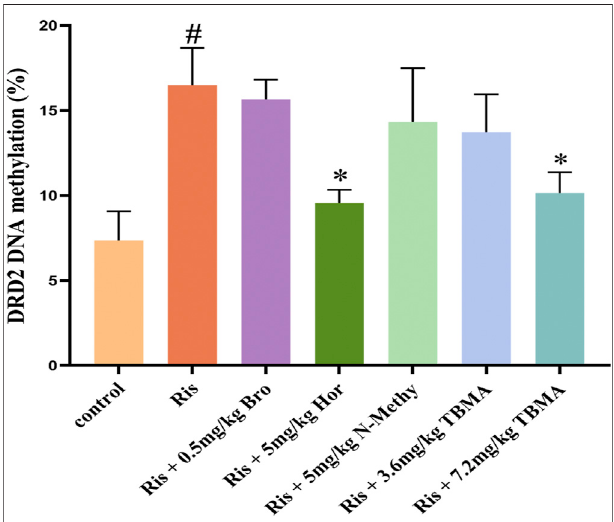
FIGURE5| DRD2methylationstatus.Dataarepresentedasthemean± SD ( n =3per group). ( # p < 0.05versusthecontrolgroup; *p < 0.05versusthe Ris group). Bro = bromocriptine; Hor = hordenine; N-Methy = N-methyltyramine; Ris = risperidone; TBMA = total barley maiya